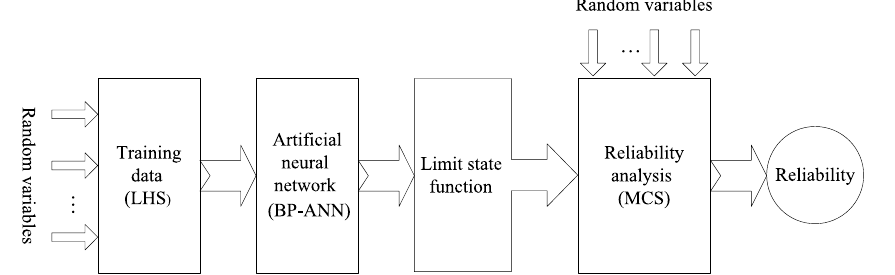
Figure 4. Procedure of the ANN-based MCS.